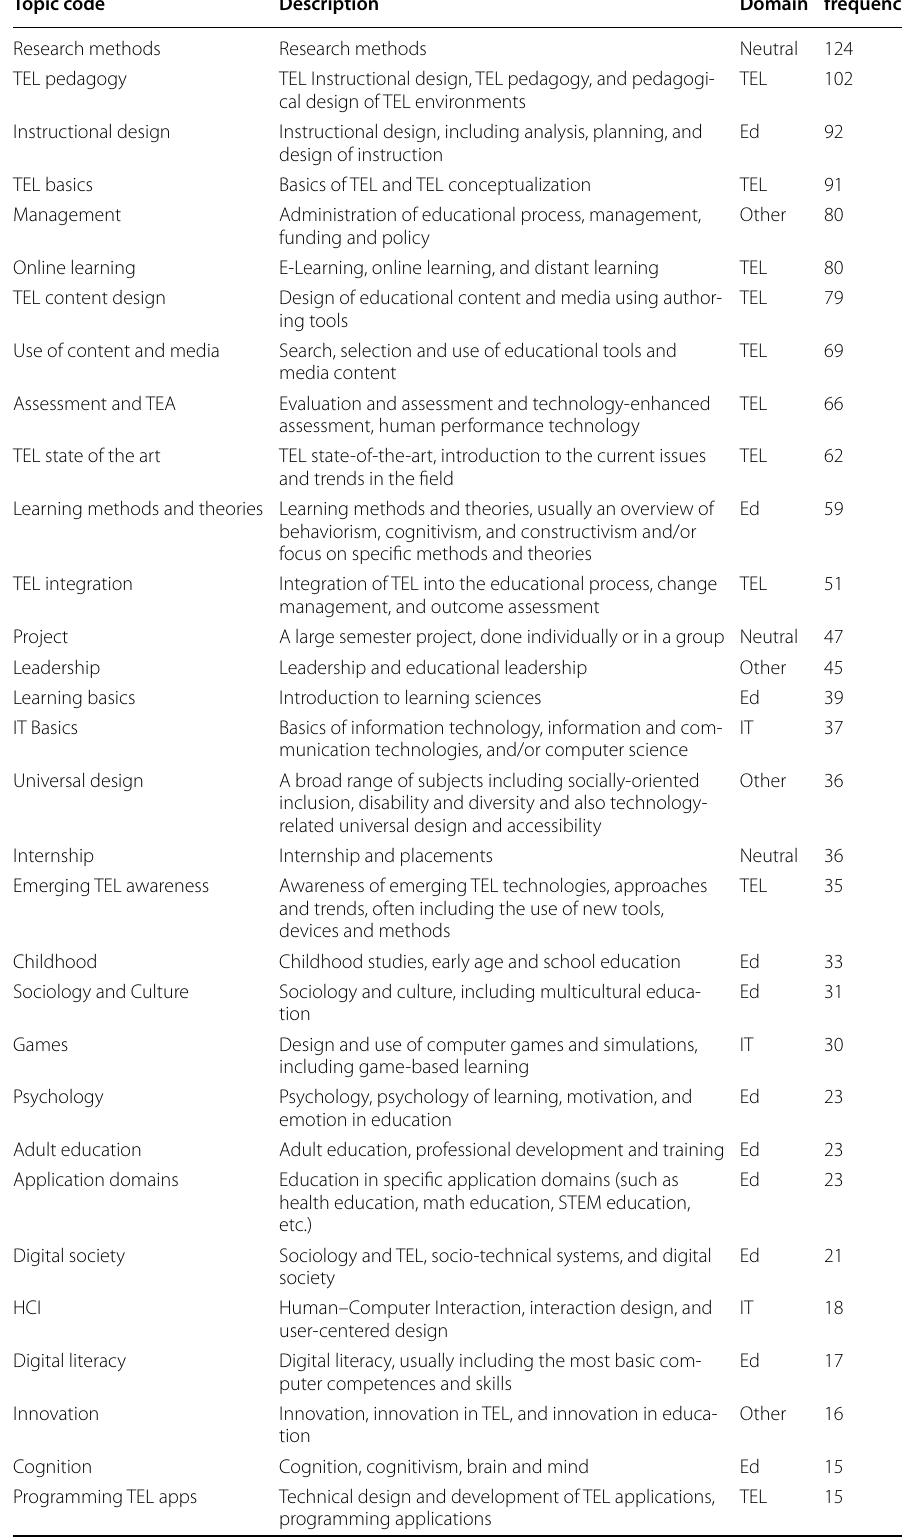
Table 3 Descriptions of the TEL curricula topic